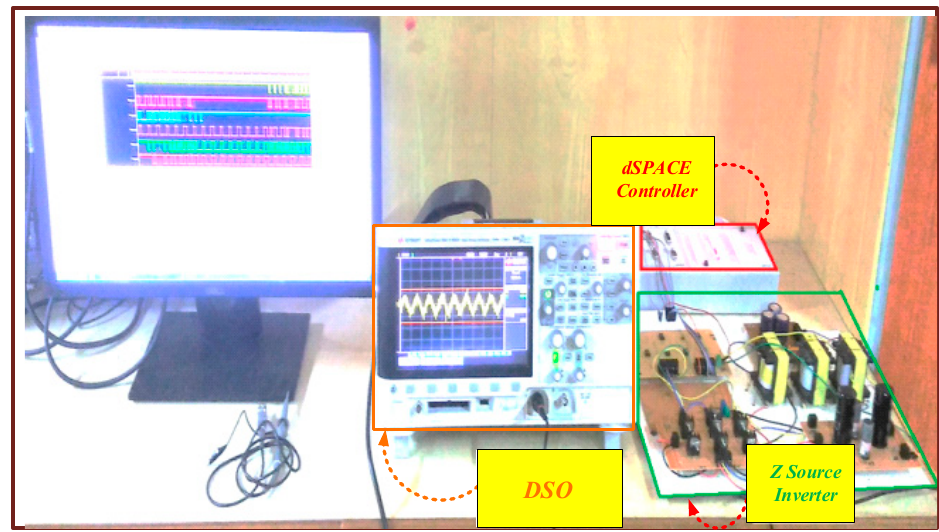
Figure 18. Hardware setups of PSO based MPPT with ZSI.